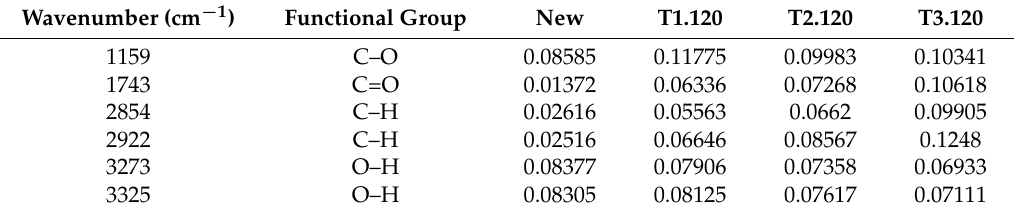
Figure 5. FTIR Spectra of transformer insulation paper for at aging temperature 120 °C and 150 °C for 1008 h. Table 3. Intensity of peak absorbance of functional groups of paper samples at temperature 120 °C.